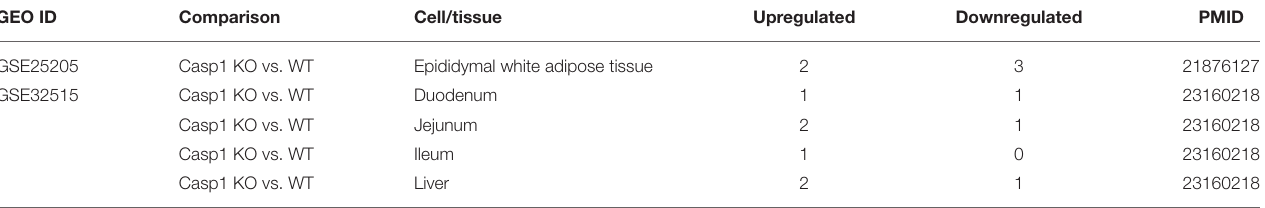
TABLE 9 | Caspase-1 deficiency microarrays in the National Institutes of Health (NIH)–National Center for Biotechnology Information (NCBI)–Gene Expression Omnibus (GEO) datasets database (https://www.ncbi.nlm.nih.gov/gds/) were collected to analyze the expression changes of organelle crosstalk regulators (OCRGs) ( p < 0.05, |logFC| > 1).